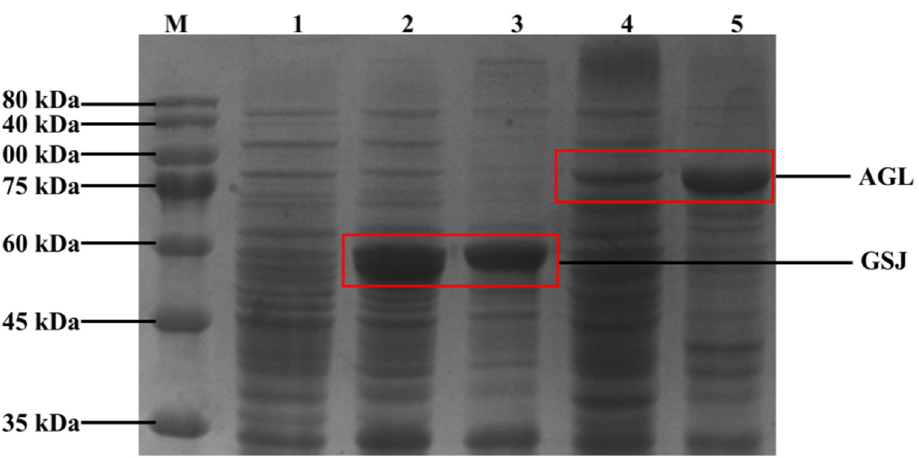
Figure 2. SDS-PAGE analysis of recombinant α -glucosidase. Lane M, protein marker; Lane 1, Control ( B. Subtilis 168/pMA5 crude enzyme); Lane 2, B. Subtilis 168/pMA5- gsj crude enzyme; Lane 3, B. Subtilis 168/pMA5- gsj broken cell precipitate; Lane 4, B. Subtilis 168/pMA5- agl crude enzyme; Lane 5 B. Subtilis 168/pMA5- agl broken cell precipitate.